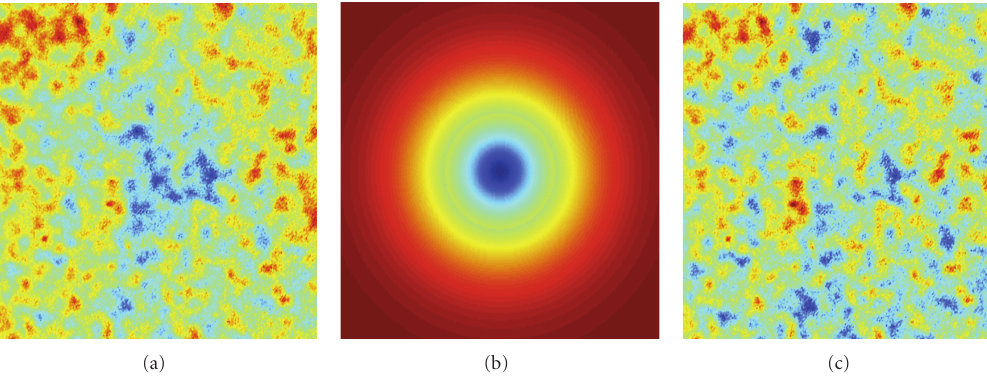
Figure 13: (a) CMB temperature fluctuations obtained from WMAP data, centred in the position of the Cold Spot. (b) best fit of a texture profile to the data, according to (14). (c) CMB map, at the position of the Cold Spot, after the subtraction of the best-fit texture